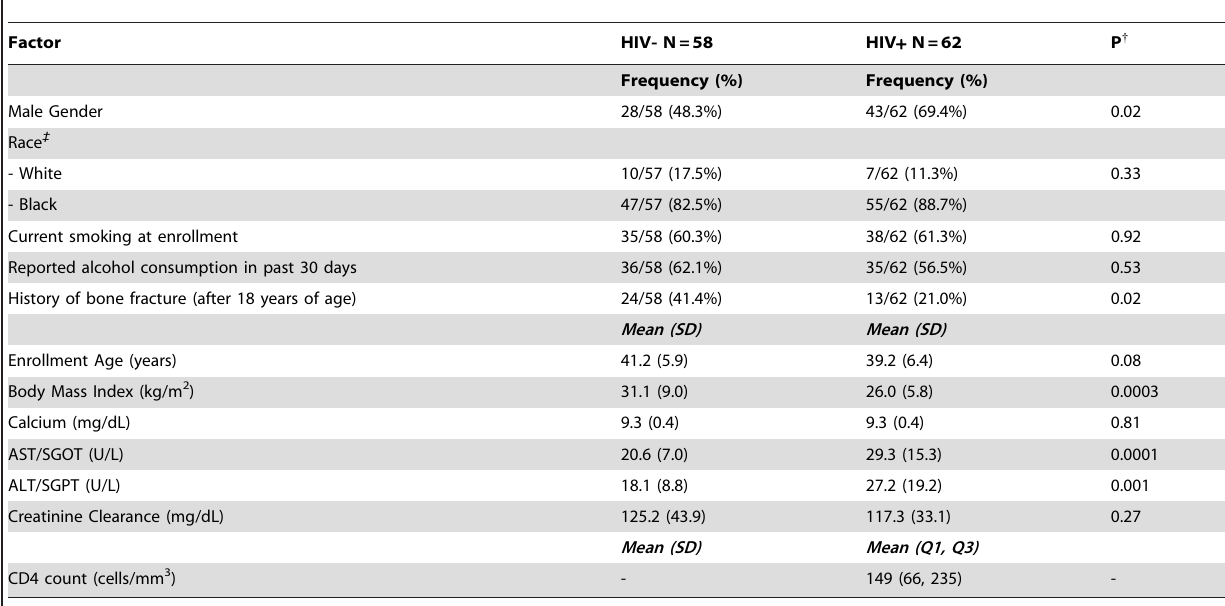
Table 1. Demographic and clinical characteristics of study population.